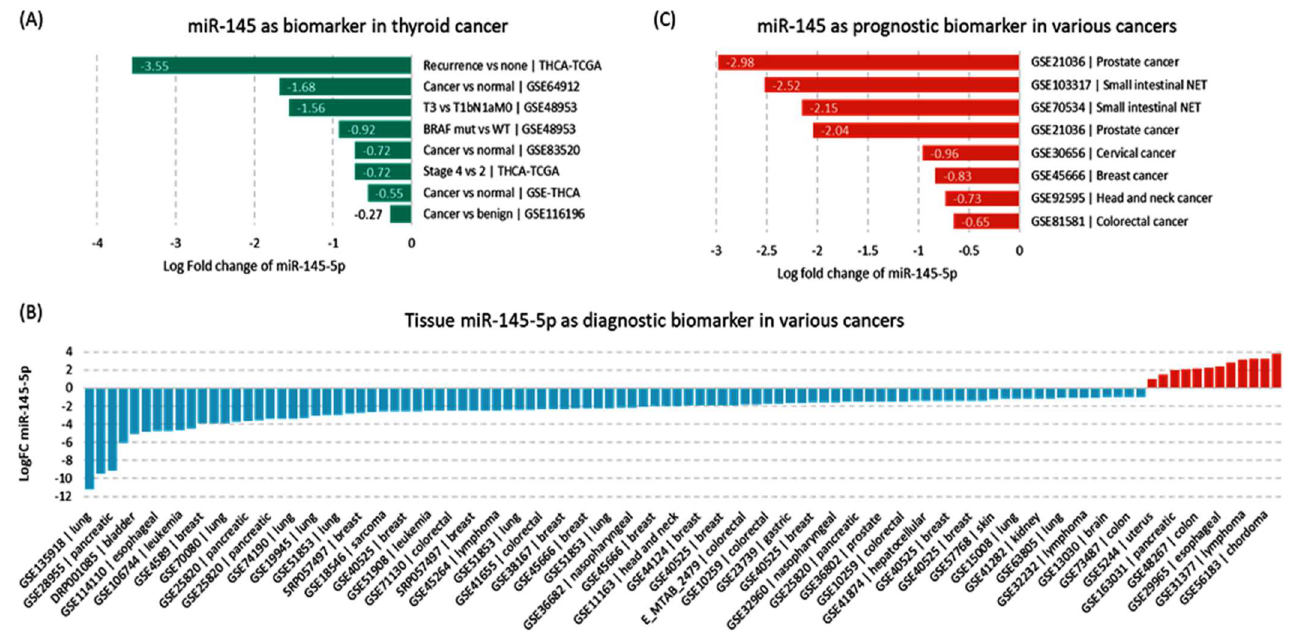
Figure 4. Expression pattern of miR-145-5p in public repositories of cancer. ( A ) Expression in thyroid cancer tissues. ( B ) Expression in other cancer tissues. ( C ) Expression in aggressive versus indolent tissues samples. Data source: dbDEMC database (https://www.biosino.org/dbDEMC/search) (last accessed: 8 August 2022).